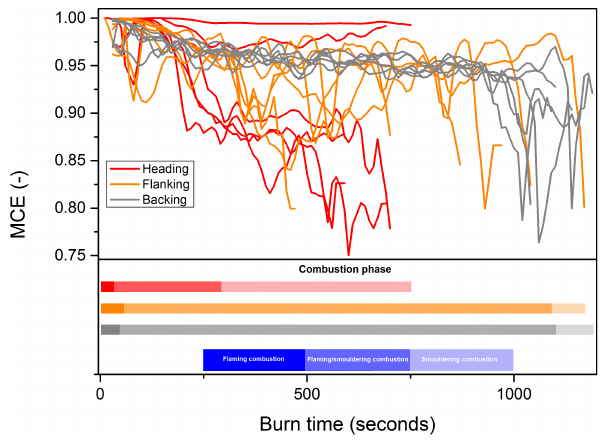
Figure 5. Time series of excess mixing ratios for different emissions species and three different fire spread modes: (a) CO 2 ; (b) CO; (c) CH 4 ; (d) N 2 O. Note that each line of a particular colour rep- resents one experimental replicate.